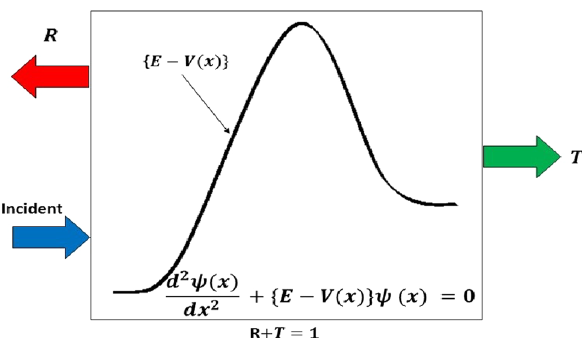
Table 1 A brief overview of the Scattering in conduction wire Cosmological particle creation connection between the Symbol Physical interpretation Symbol Physical interpretation scattering problem in quantum mechanics to that of x Distance τ Conformal time cosmological particle creation events V(x) Potential − m 2 (τ) Time dependent mass parameter (τ) Mode function in Fourier space (cid:12)( x ) Wave function φ k N s No. of scatterers N s No. of non-adiabatic events (cid:9) x Distance between scatterers (cid:9)τ Time between non-adiabatic events ξ Localization length μ k Mean particle production rate (τ) Particle occupation number ρ( x ) Resistance n k Energy eigen value k 2 Wave number of Fourier modes N c Number of channels N f Number of